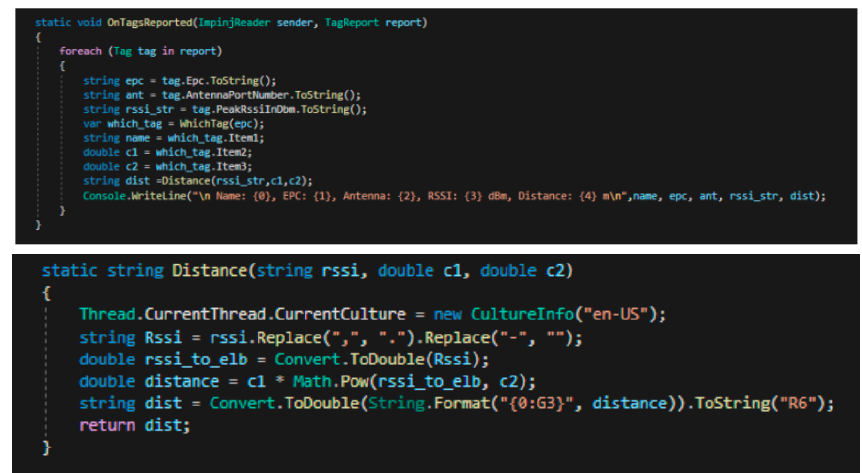
Figure 11. Reader control interface.